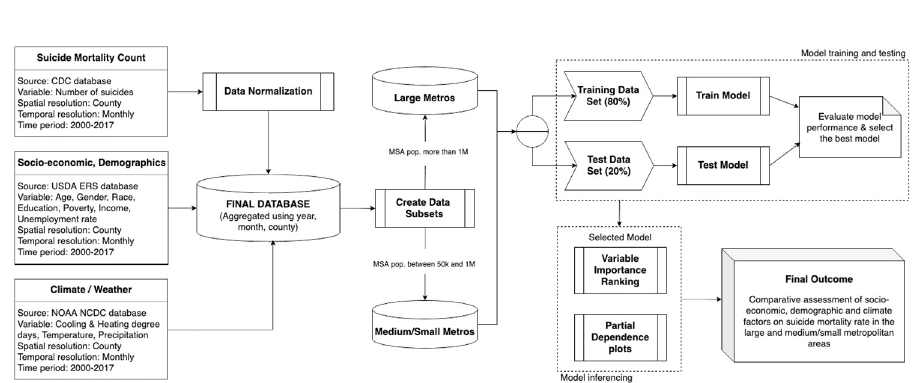
Fig 2. Schematic of the proposed data-driven research framework.